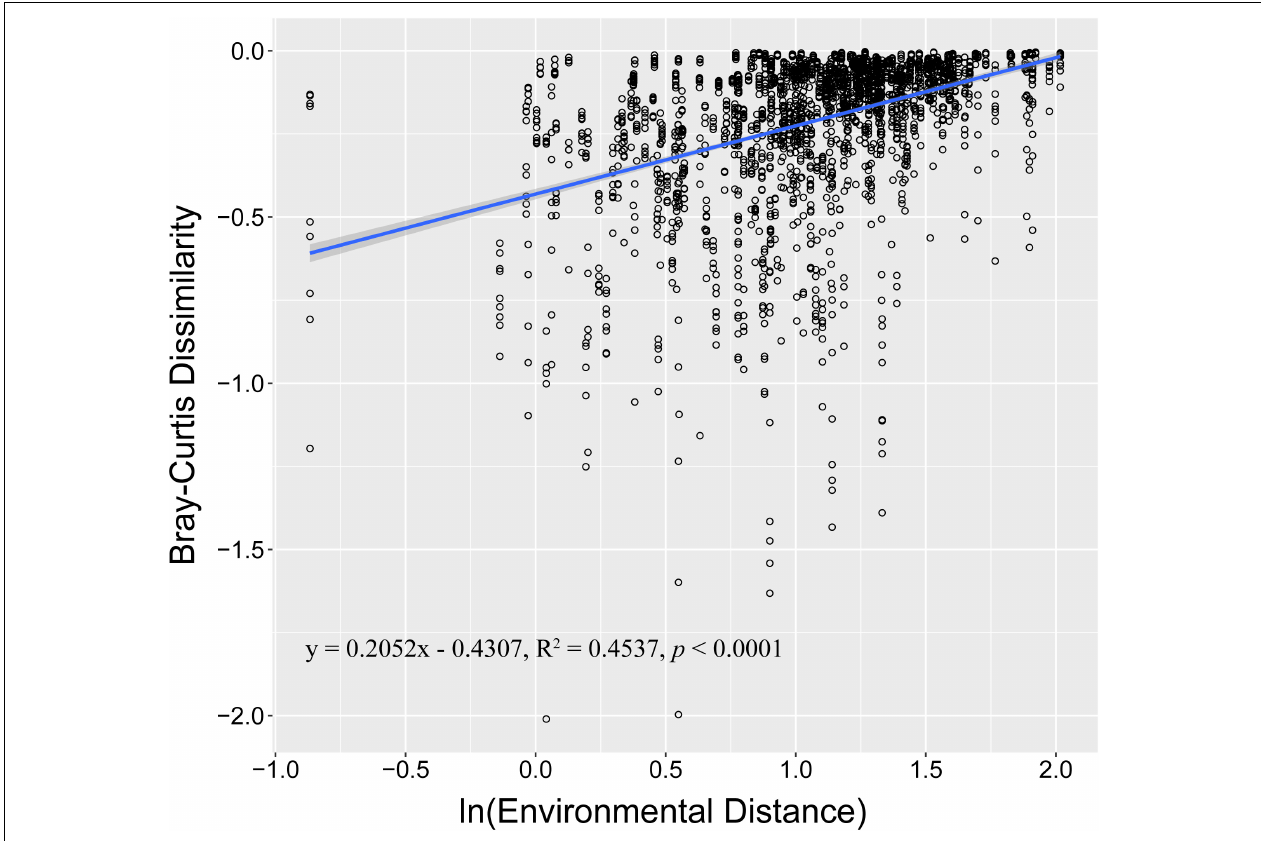
FIGURE 3 | Regressions between environmental changes and microbial community similarity. The X-axis indicates the ln-transformed environmental distance (Euclidean), and the Y-axis indicates the ln-transformed Bray–Curtis distance. The solid blue line indicates the linear spline fit. The gray shadow represents the 95% confidence